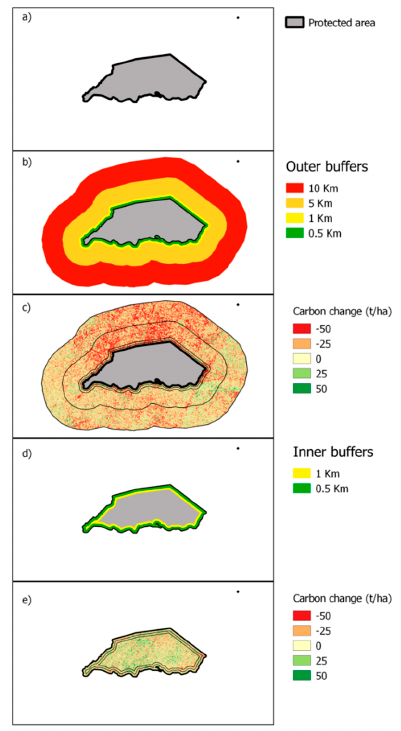
Figure 2. Schematic representation of the methodology adopted for constructing concentric bands of 0–0.5 km, 0.5–1 km, 1–5 km, and 5–10 km within and the outer buffers of PAs for estimating mean carbon change.